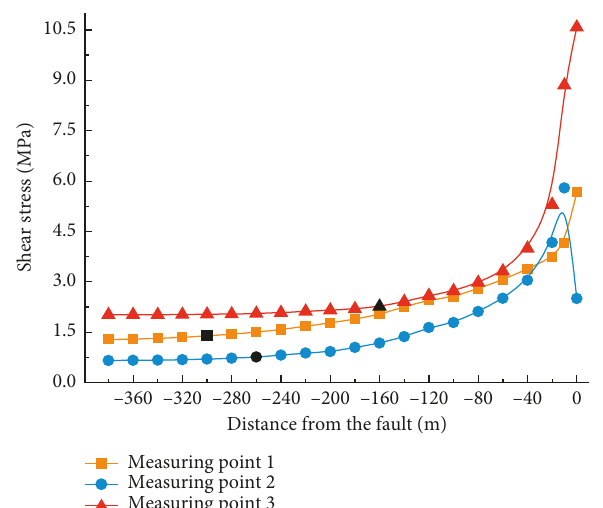
Figure 8: The states of shearing at the fault during the working face advancing.